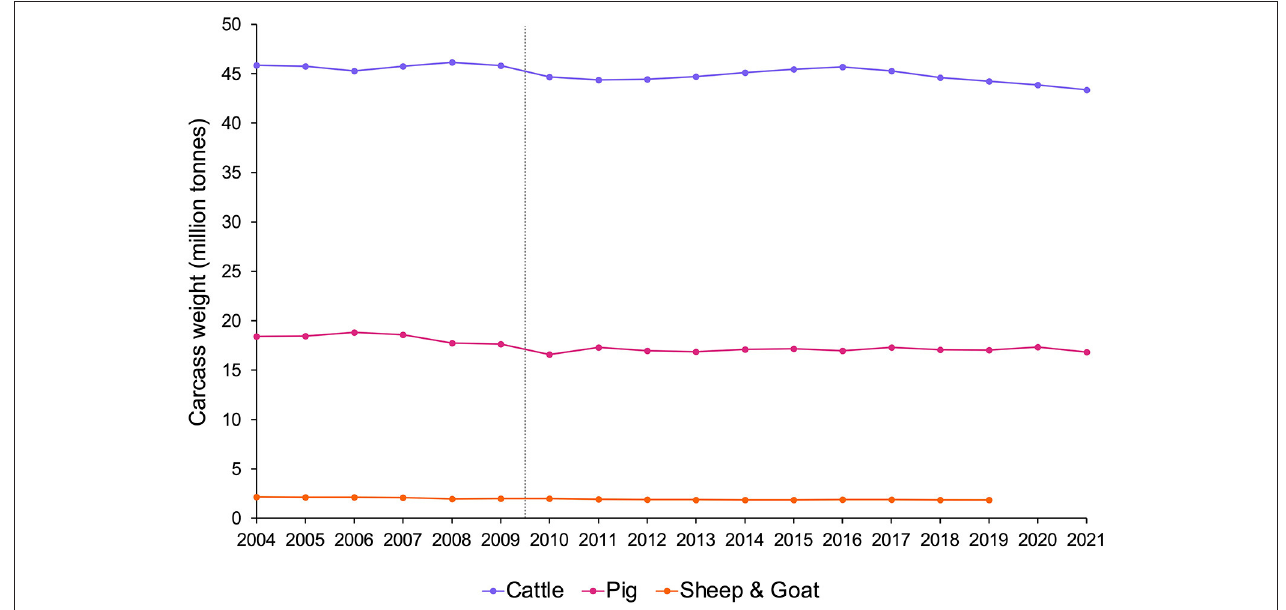
FIGURE 3 | Meat production (million tonnes of carcass weight) in EU countries from 2004–2021 by species, estimated from Eurostat data [sources: (apro_mt_lscatl), (apro_mt_lspig), (apro_mt_lssheep), and (apro_mt_lsgoat)]. The grey dotted line indicates the point at which the Treaty of Lisbon recognized that all animals are sentient (2009). Note that after the Treaty of Lisbon was signed, although animal protections subsequently changed, meat production levels remained the